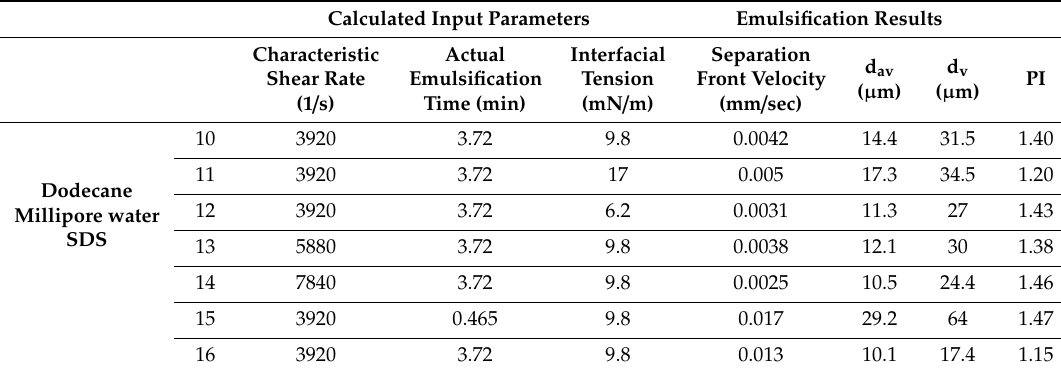
Table 4. Quantitative results of the experiments with Piston 2.